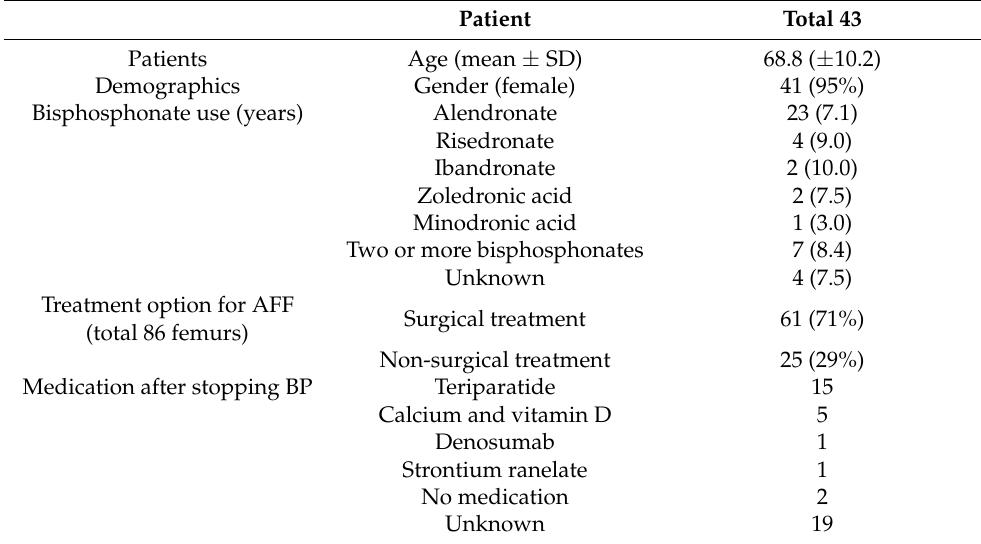
Table 2. Overall characteristics of patients with BP-related bilateral